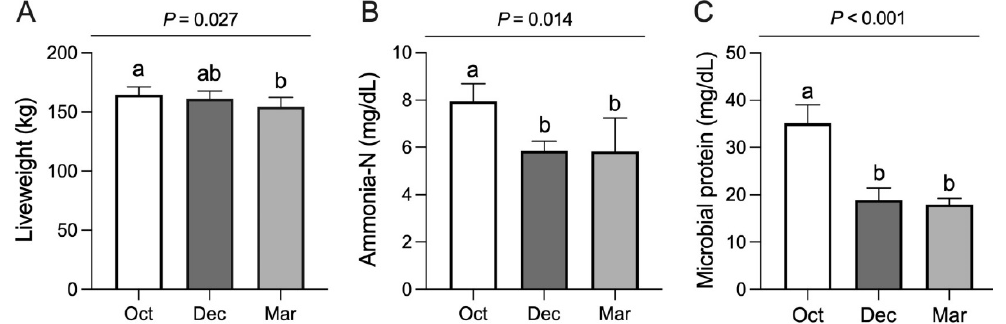
Figure 1. Dynamic changes in ( A ) liveweights, concentrations of ( B ) ammonia-N and ( C ) microbial crude protein in the ruminal fluid of grazing yaks during the cold season. Values with different letters represent significant differences among groups ( p < 0.05). Results are presented as mean ± standard deviation.